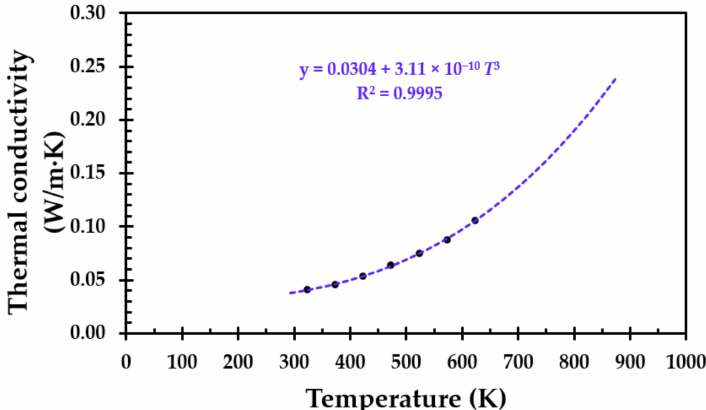
Figure 2. Thermal conductivity of the thermal insulation (ProRox PSM 971, 50 mm) as a function of the absolute temperature. Data from Appendix A, Table